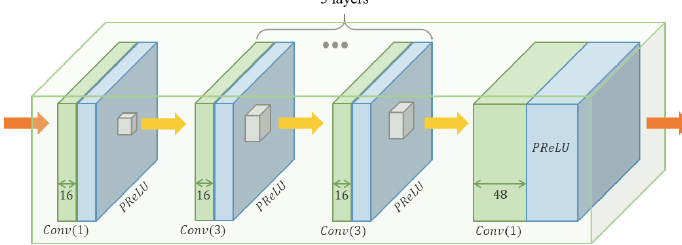
Figure 3. Visualization of the mapping